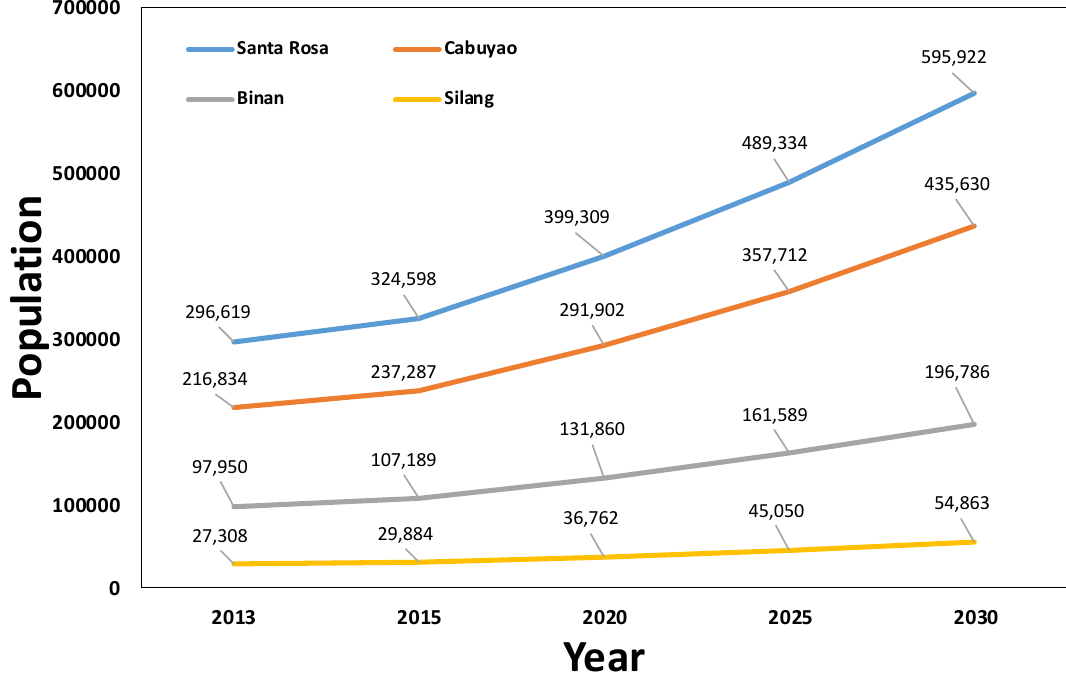
Figure 4. Plot showing trend in population growth in the study area.